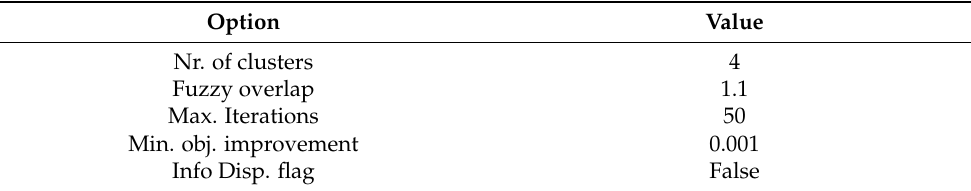
Table 3. Optional parameters used for the fuzzy c-means clustering algorithm in MATLAB. Option